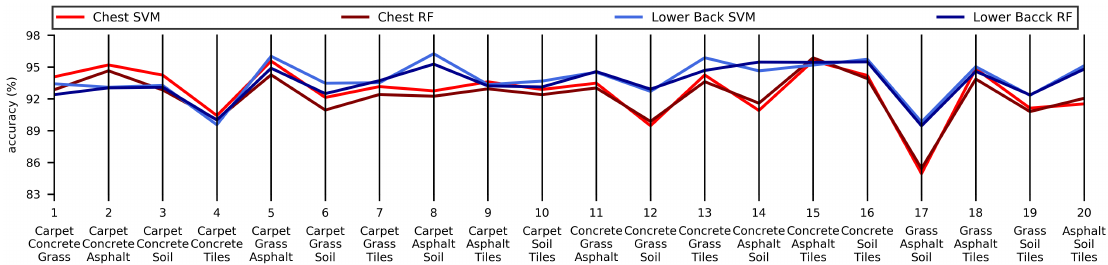
Figure A1. Parallel coordinate chart of ternary classification . The results were obtained with all features set (194 features) for each classifier and for each sensor location.